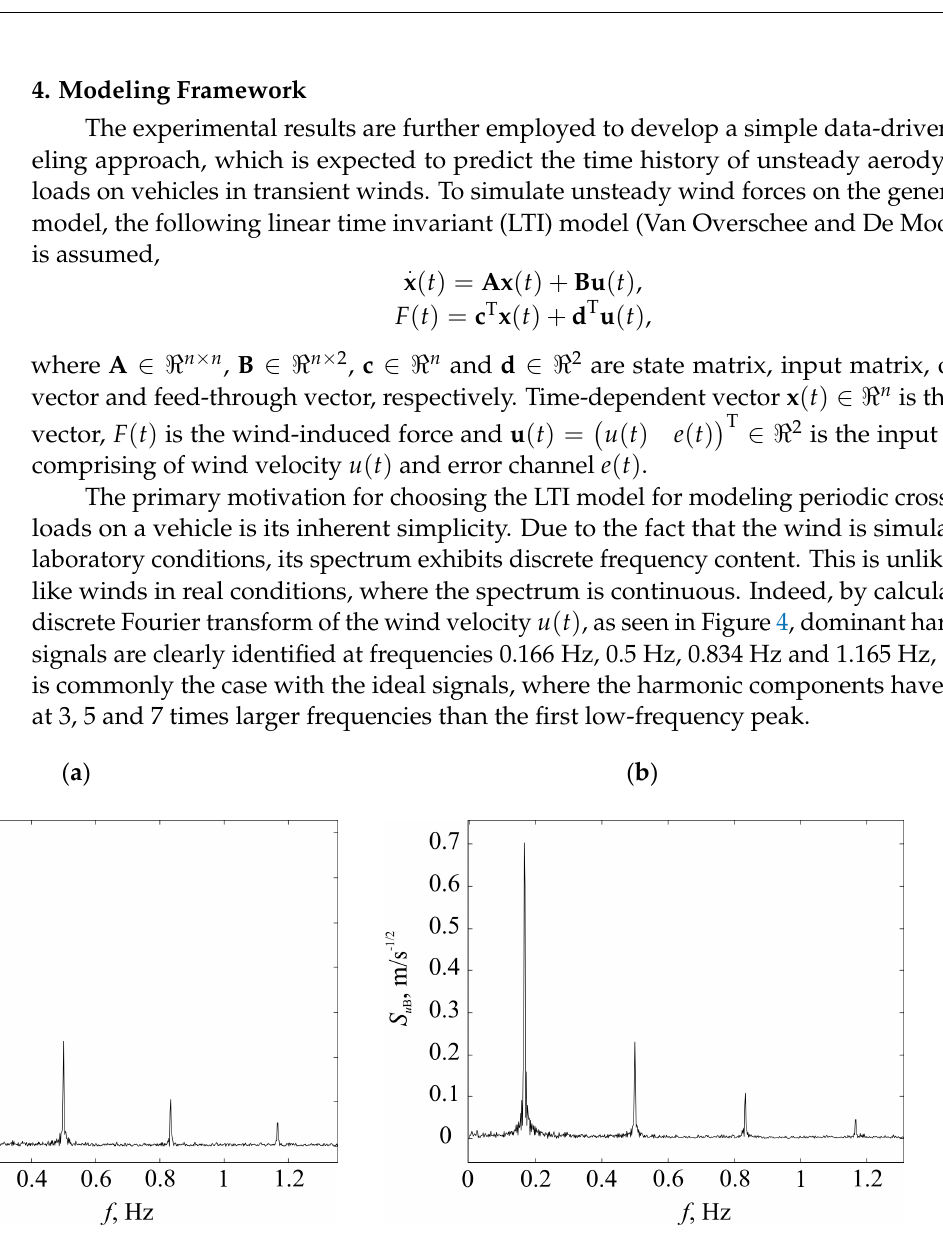
Figure 4. The unfiltered amplitude spectrum of longitudinal velocity fluctuations (discrete Fourier transform of the measured wind velocity): ( a ) model A and ( b ) model B.